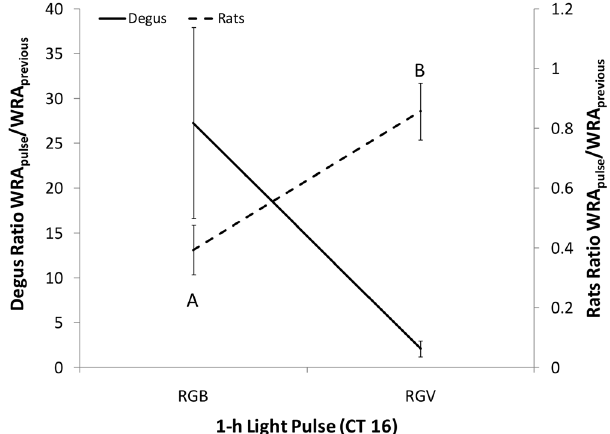
Figure 7. Acute effects of light on WRA. Ratio between wheel running activity (WRA) performed during the 1-hour light pulse (RGB or RGV) at CT16 and WRA performed the previous day at the same time. The left axis indicates the ratio for degus (continuous line, n = 8 for each light pulse) and the right axis indicates the ratio for rats (dashed line, n = 4 for each light pulse). Data are expressed as the mean ± SEM. Different letters indicate statistically significant differences (Student’s t-test, p <